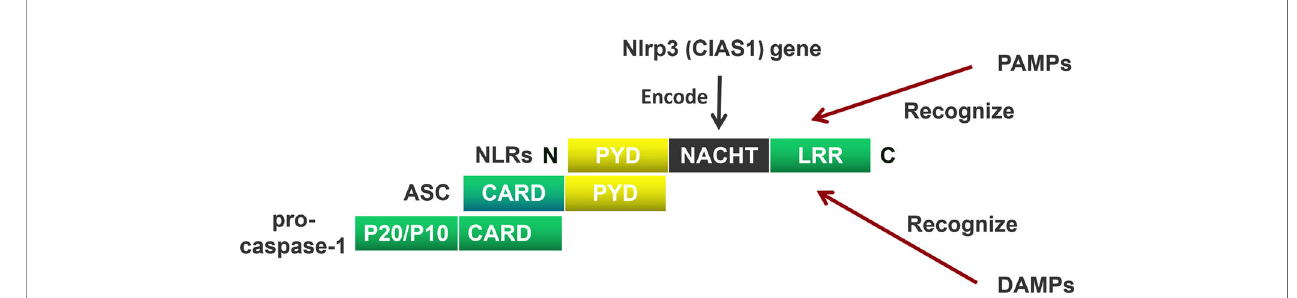
FIGURE 1 | The Composition of the NOD-like receptors (NLRs). NOD-like receptors (NLRs) are mainly composed of a carboxyl (C) terminal, a central terminal, and an amino acid (N) terminal. The C-terminus includes a leucin rich repeat (LRR), the center terminus includes NACHT, and the N-terminus includes a pyrin domain (PYD). The C-terminal LRR recognizes the pathogen-associated molecular patterns (PAMPs) and damage-associated molecular patterns (DAMPs), the central- terminal NACHT encodes by Nlrp3 (CIAS1) gen. The N-terminal CARD interacts with the adaptor protein through PYD-PYD. Apoptosis-associated speck-like protein containing a CARD (ASC) recruits pro-cysteinyl aspartate speci fi c proteinase-1 (pro-caspase-1) through CARD domain to activate downstream